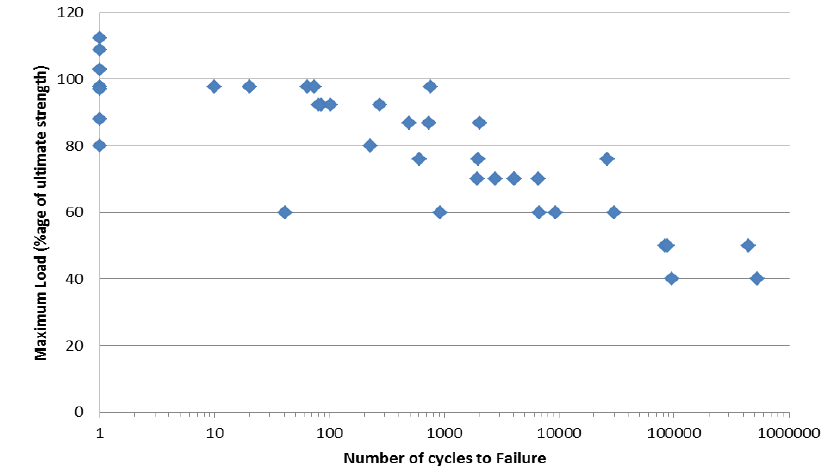
Figure 4: Stress-life data for bamboo culm